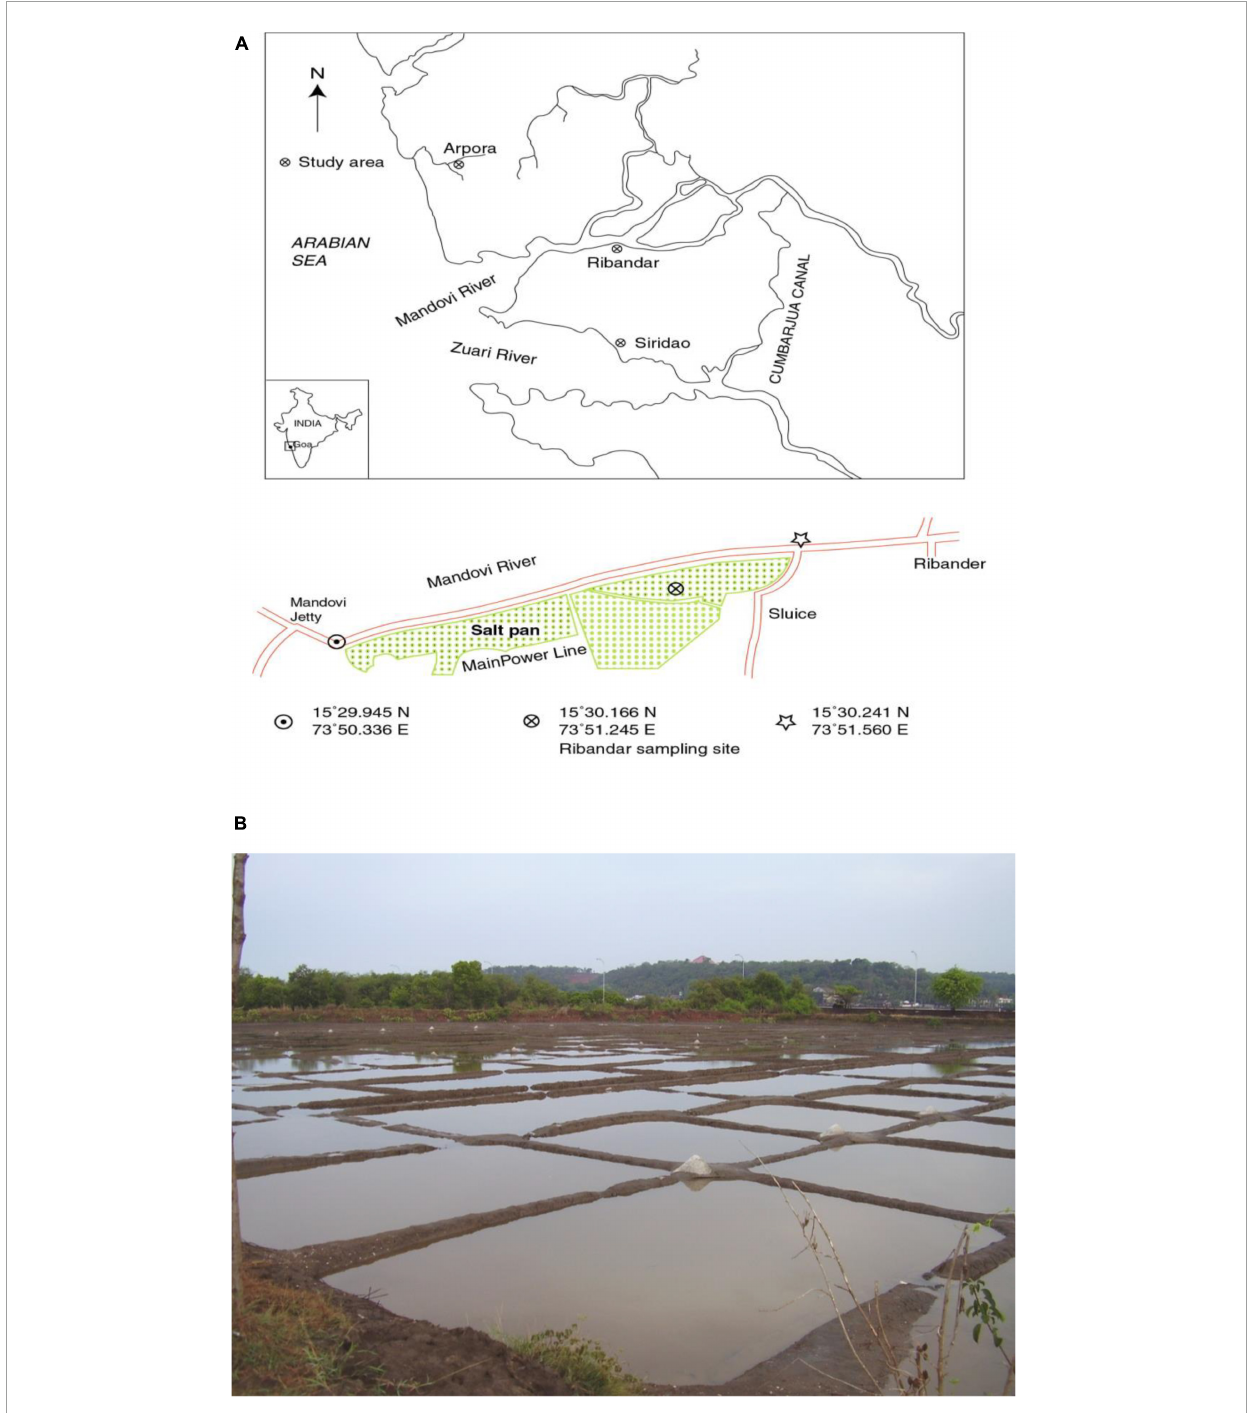
FIGURE1 (A) Map showing location of Ribandar saltern in Goa, India and (B) study site.